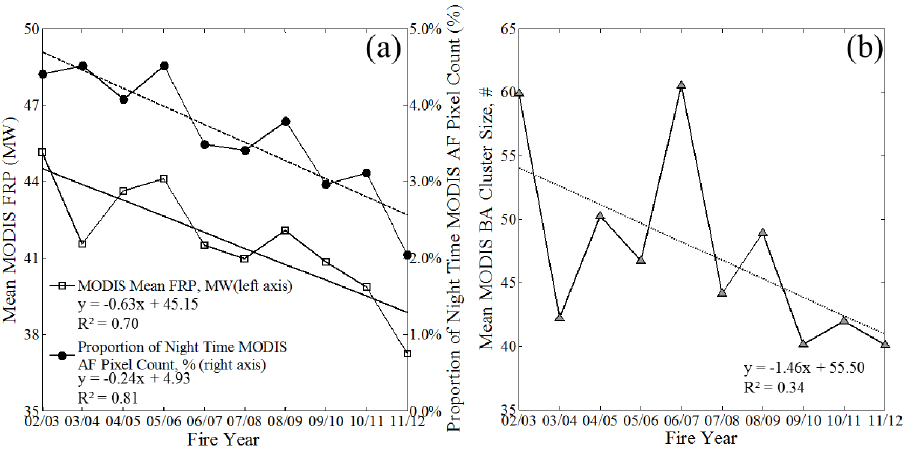
Figure 4. Decadal trends in ( a ) the mean FRP and proportion of total active fire pixels detected at night; and ( b ) mean burned area cluster size measured by MODIS Terra and Aqua across the CAR between 2002 and